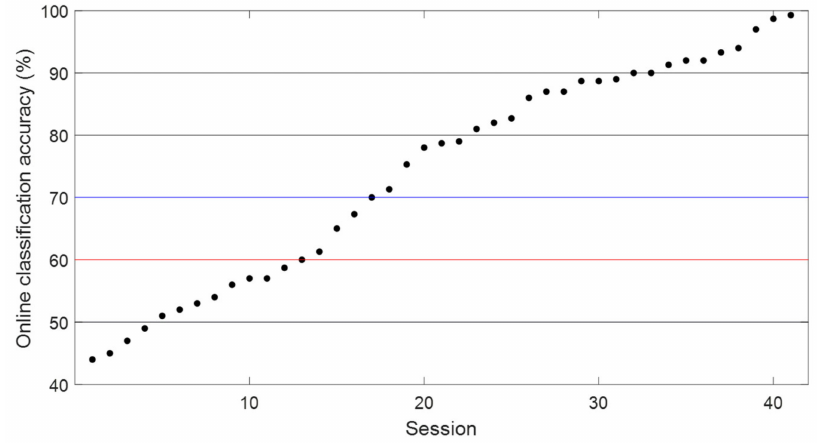
Figure 1. Distribution of classification accuracy for 41 online MI-BCI sessions in increasing order. Sessions above the blue line (classification accuracy ≥ 70%) and sessions below the red line (classification accuracy < 60%) were categorized as the high- and low-performance groups,